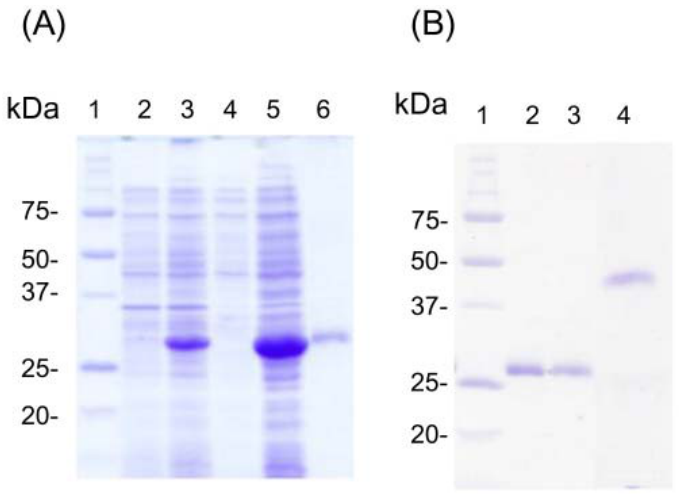
Figure 2. SDS-PAGE analysis of recombinant antibodies against AM and AS. A) Analysis of the scFv. Lane 1, marker proteins; Lane 2, total protein before IPTG induction; Lane 3, total protein after IPTG induction; Lane 4, soluble fraction, Lane 5, insoluble fraction; Lane 6, purified scFv. B) Analysis of the Fab. Lane 1, marker proteins; Lane 2, purified VH-CH1; Lane 3, VL-CL; Lane 4, refolded Fab (non-reducing